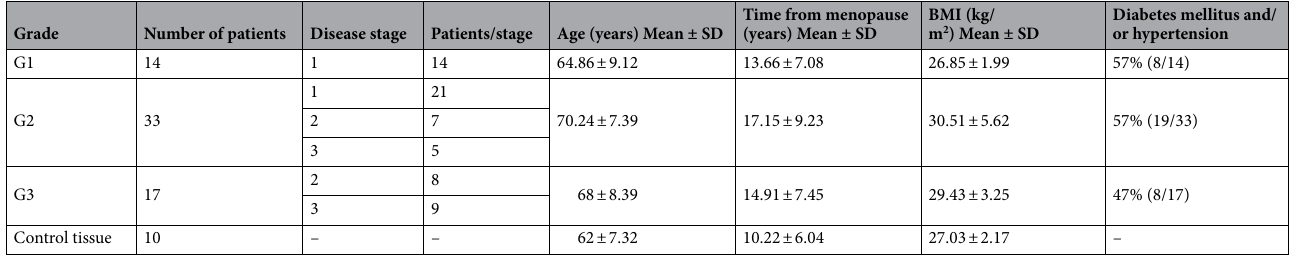
Table 1. Clinical characteristics of the